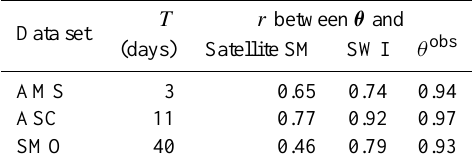
Table 3. Parameter T and correlation coefficient between model SM ( θ ) and satellite SM, before and after SWI transformation and rescaling. Results are presented for the entire catchment. Data